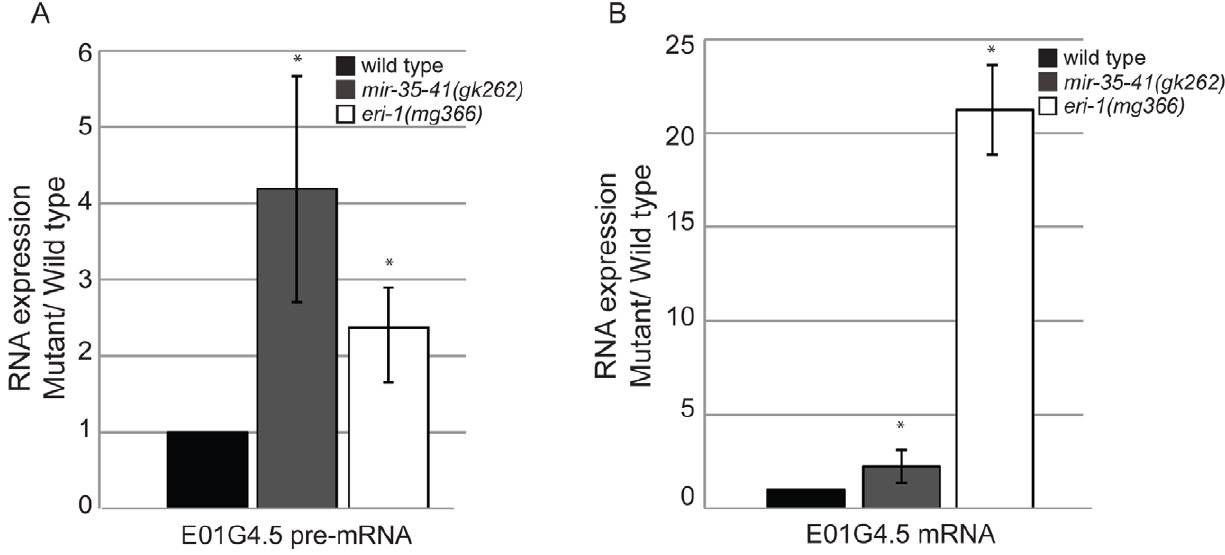
Figure 3. Mis-regulation of the E01G4.5 endo–siRNA target in mir-35-41 mutants. RT-qPCR of E01G4.5 pre-mRNA (A) and mature mRNA (B) normalized to 18S rRNA and compared to wild type levels (mean 6 s.e.m., n=3, *, P , 0.05).